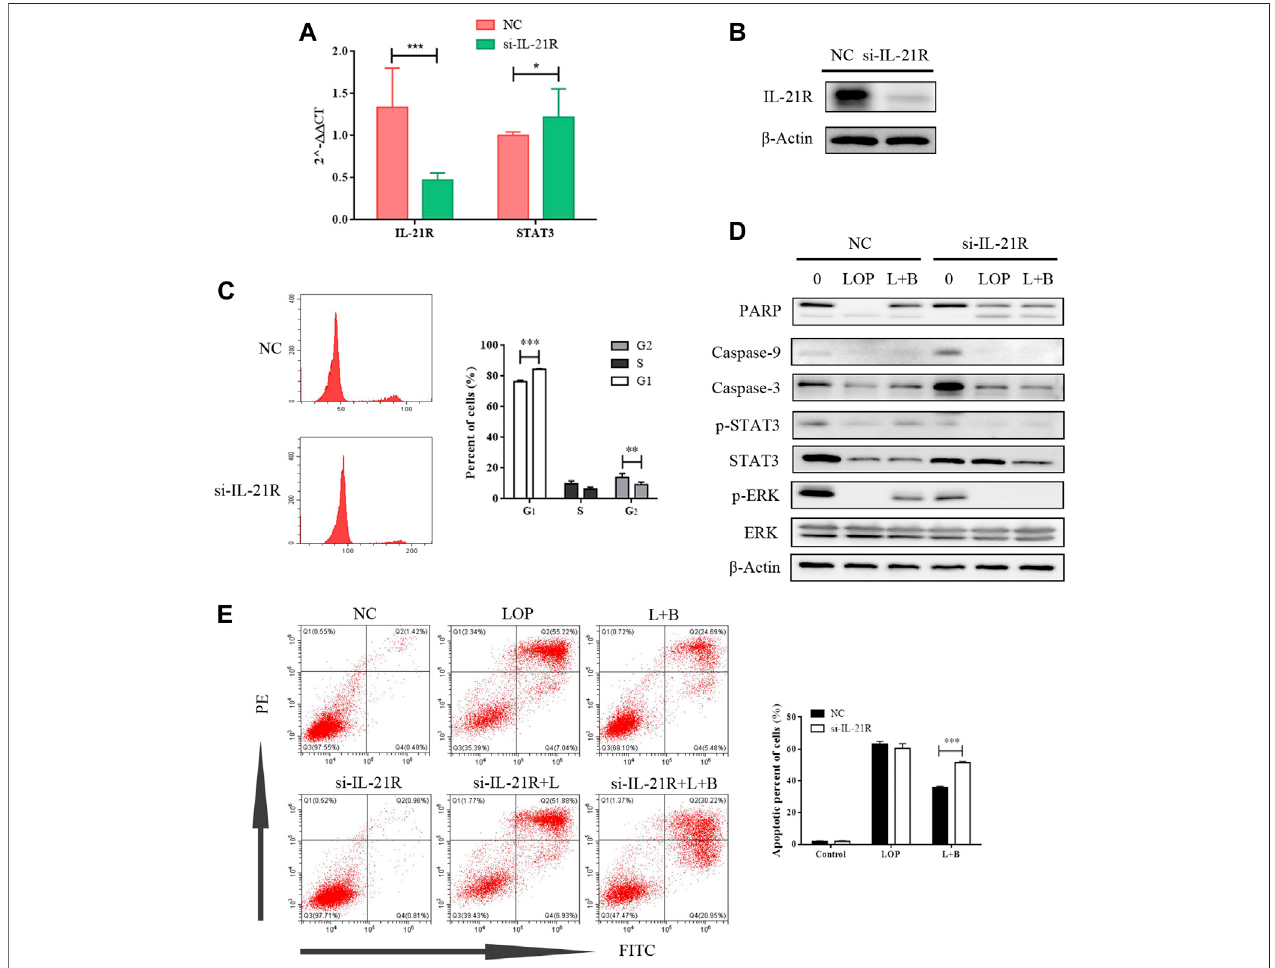
FIGURE 9 | The cell activity of interstitial cells of Cajal can be inhibited by knocking down IL-21R. (A) QPCR showed that IL-21R was knocked down at the transcriptional level; (B) the expression of IL-21R on the cell surface decreased after IL-21R siRNA transfection; (C) the changes in the cell cycle were detected by fl ow cytometry. * p < 0.01, *** p < 0.001. (D) the WB images of caspase pathway and the phosphorylation level of STAT and ERK. (E) apoptosis was detected by fl ow cytometry. ** p < 0.005, *** p <